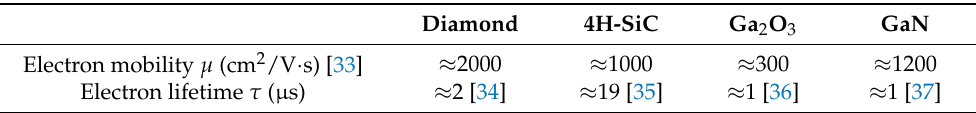
Table 3. Electron mobility and electron lifetime for diamond, 4H-SiC, Ga 2 O 3 and GaN. Reference to source is shown in square